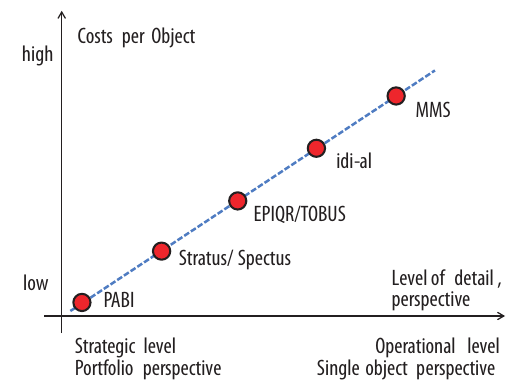
Fig. 4. Qualitative rating of maintenance and refurbishment planning and budgeting